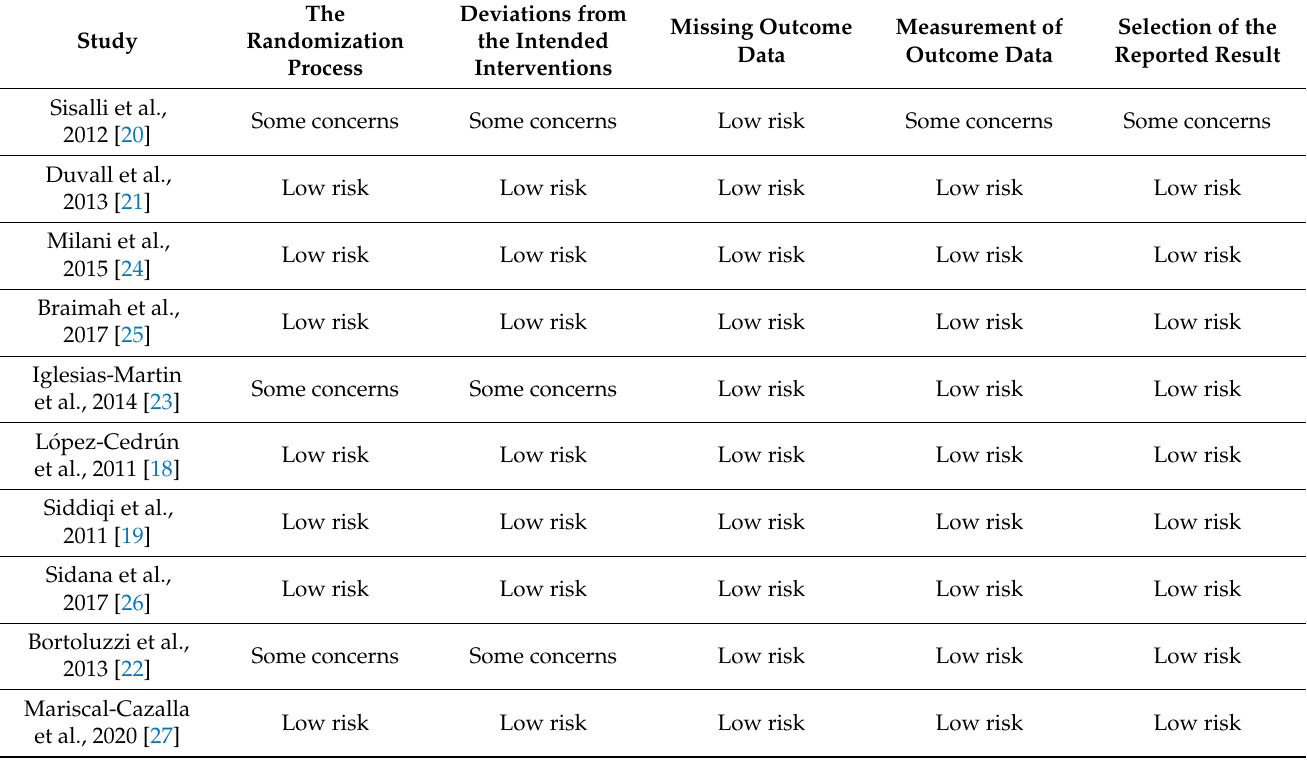
Table 2. Risk of bias of randomized clinical trials, assessed through the ROB2 tool